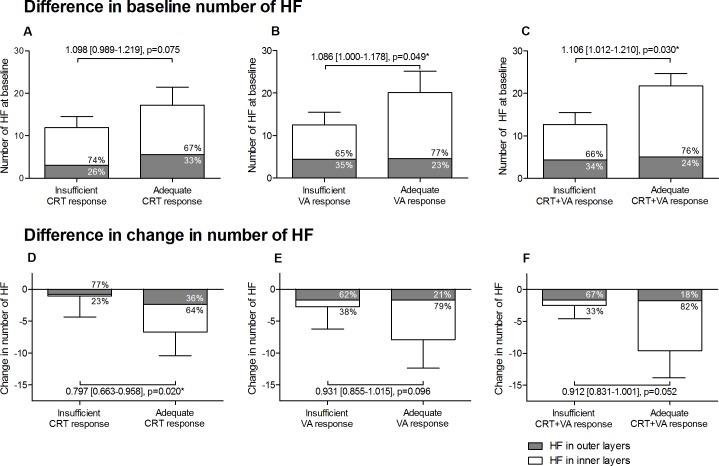
Difference in number of HF at baseline, and change in HF between eyes with adequate response versus insufficient response.Mean number of HF at baseline in groups based on insufficient and adequate CRT response (A); insufficient and adequate VA response (B); and insufficient and adequate combined CRT + VA response (C). Mean change in number of HF in groups based on insufficient and adequate CRT response (D); insufficient and adequate VA response (E); and insufficient and adequate combined CRT + VA response (F). The distribution of HF in the inner and outer retinal layers is displayed as a percentage. The values represent the odds ratio with corresponding 95% confidence interval and p-value. The odds ratio of adequate response is 1.106, which can be interpreted as an increase, or chance, for adequate response by 10.6% for every HF at baseline; when the number of HF at baseline increases by 10, the chance for adequate response increases exponentially by 1.10610 = 2.74 or 274%. The bars represent mean ± 95% confidence interval and are based on descriptive statistics. *P<0.05.